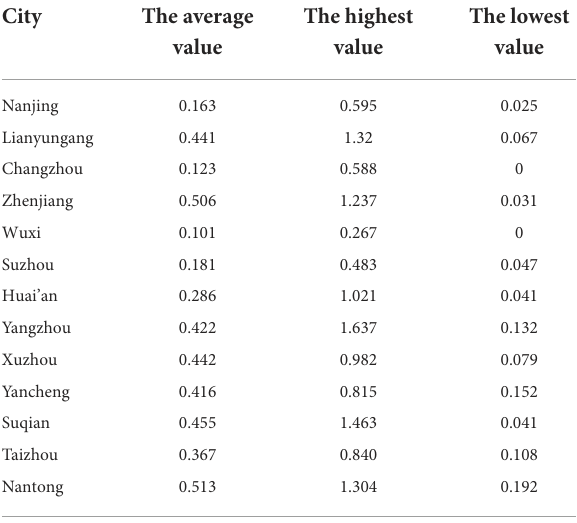
TABLE 2 The parameter setting for different models. Model Parameter